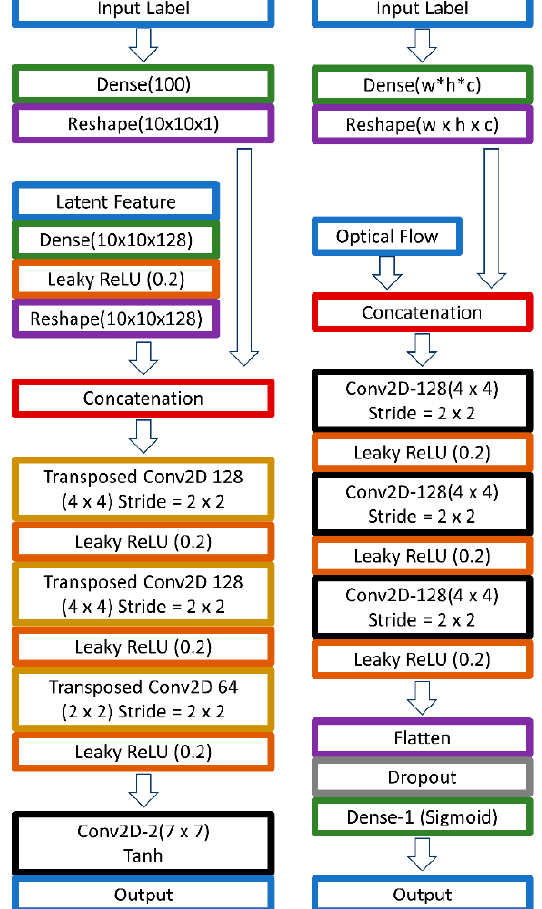
Figure 8. The proposed conditional Compact DC-GAN architecture that produces 80 × 80 synthetic onset-apex optical flow images. The network on the side is the architecture of the generator network, while the network on the right side is the architecture for the discriminator network.